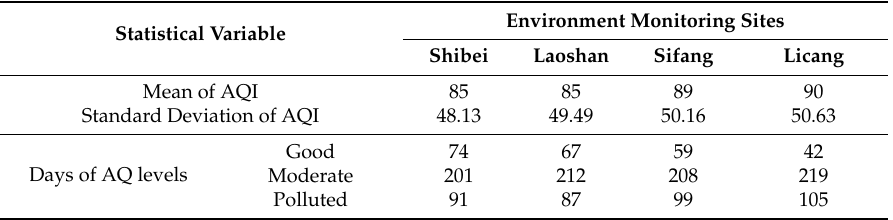
Table 2. Statistical characteristics of AQI (Air Quality Index) and days of dominant air pollutants at the four